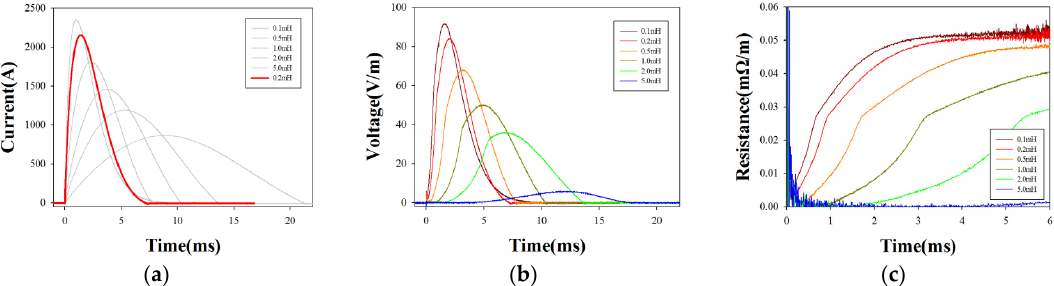
Figure 3. Fixed impulse test platform L = 0.2 mH while varying R: ( a ) impulse current waveform; ( b ) impulse voltage waveform; ( c ) resistance response waveform.